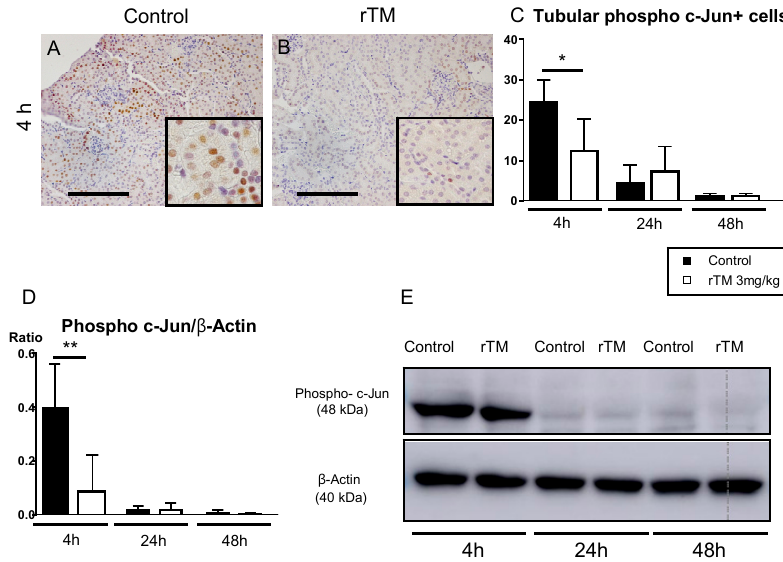
Figure 5. Expression of Kim-1 (kidney injury molecule-1) in the kidney. Representative photograph of Kim-1 expression in the kidney after lipopolysaccharide (LPS) injection ( A , B ). In saline-treated control mice, Kim-1-positive tubules were present in the kidney ( A ). Kim-1-positive tubules were significantly visible in the rTM-treated mice, whereas they were not visible in the control mice ( B ). The number of Kim-1-positive tubules in 10 × 400 fields ( C ). Expression of renal Kim-1 mRNA is shown ( D ). The panels show mean numbers and fold increase ± standard error of the mean (* p < 0.05, control mice versus rTM-treated mice). c / 10 hpf, cell numbers per 10 high-power fields. Dotted lines represent mean values from control mice without LPS. Scale bar, 50 µ m.